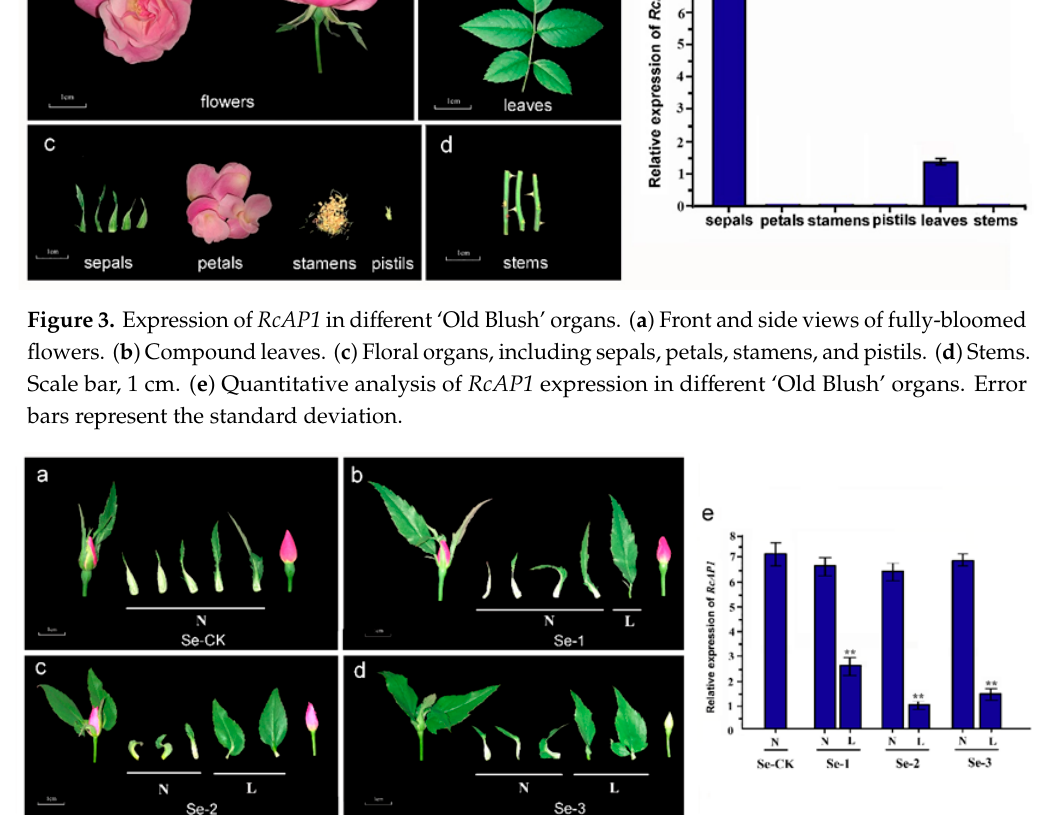
Figure 5. Quantitative analysis of RcAP1 expression in ‘Old Blush’ and ‘Viridiflora’ plants. Asterisks indicate significant differences ( p < 0.01) according to Dunnett’s test. Error bars represent the standard deviation. 2.3. Overexpression of RcAP1 in Arabidopsis Thaliana Induces Early Flowering We analyzed the plant phenotype when RcAP1 was overexpressed in wild-type (WT) A. thaliana . Seven independent T1 generation transgenic lines were detected based on hygromycin resistance, and subsequently confirmed with RT-PCR and qRT-PCR analyses (Figure 6b,c). Five representative transgenic lines were chosen for further analysis. According to the qRT-PCR data, line 2 and line 4 represent the low level overexpression, line 5 and line 7 represent the middle level overexpression, and line 1 represents the highest level overexpression of RcAP1 in A. thaliana . Lines 1, 2, 4, 5, and 7 (L1, L2, L4, L5, and L7) were screened using the selection method described above until T3 generation transgenic seeds were obtained. In total, 30 seeds were sown for five independent homozygous transgenic lines (L1, L2, L4, L5, and L7) and the WT control. The resulting plants were cultured in an incubator under long-day conditions (16-h light/8-h dark). Three of the transgenic lines (L1, L5, and L7) exhibited varying degrees of early flowering (Figure 6a and Figure S4b). The rosette leaves were counted and the days to flowering were determined (Figure 6d). Of the transgenic lines, L1 exhibited the earliest flowering (day 18 after sowing), while L5 exhibited the latest flowering (day 27 after sowing). The T3 plants of L1, L5, and L7 bloomed earlier than the WT plants, which started to bloom on day 44 after sowing. Meanwhile, L2 and L4, which exhibited low